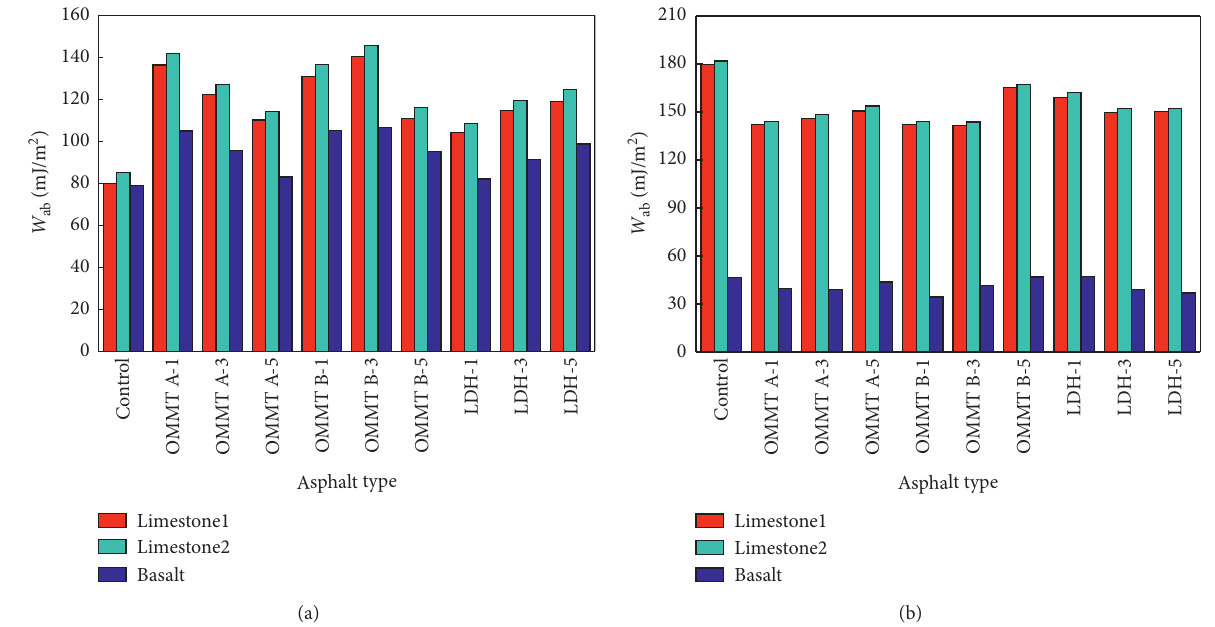
Figure 6: W and W of the bitumen with different types of limestone: (a) work of adhesion under dry conditions ( W ab abw (b) work of adhesion in the presence of water ( W